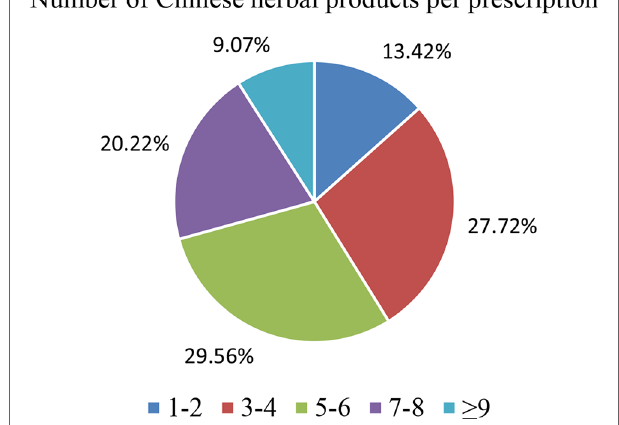
FIGURE 3 | Distribution of Chinese herbal medicine combinations in one treatment for all patients with COPD.